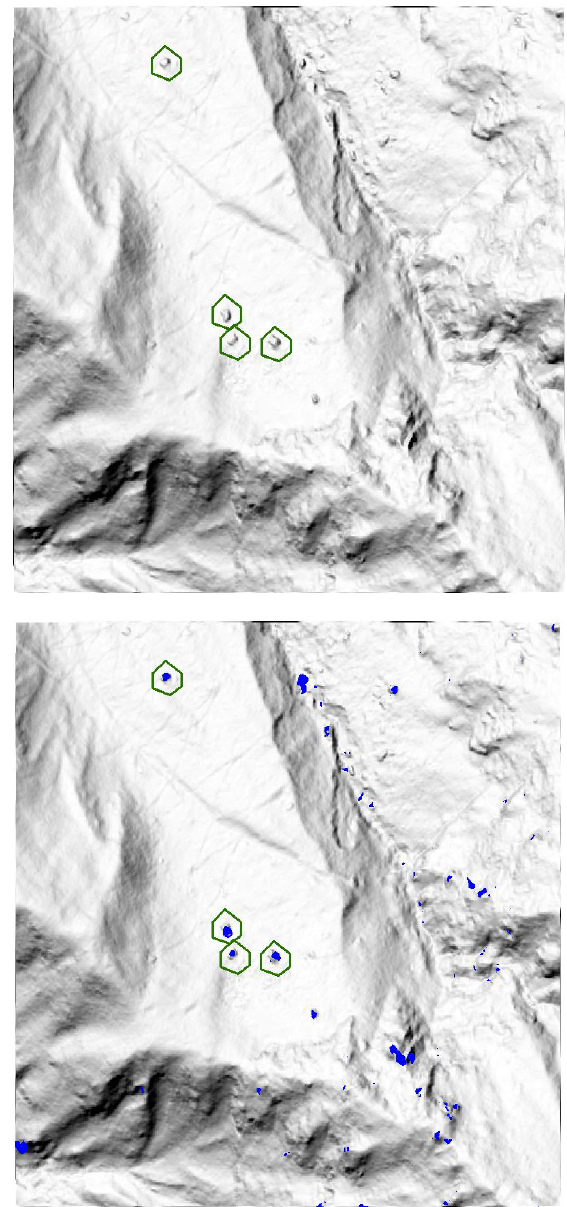
Figure 2. Green polygon on the top figure are locations of protruding rocks at region A, confirmed from the site verification, and blue patches on the bottom figure are the protruding rocks detected by our